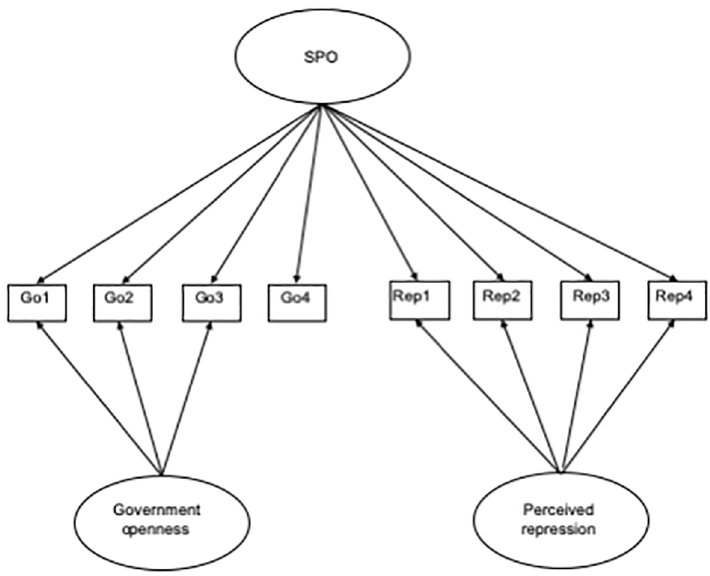
Figure 2. Alternative bifactor model (1 general factor + 2